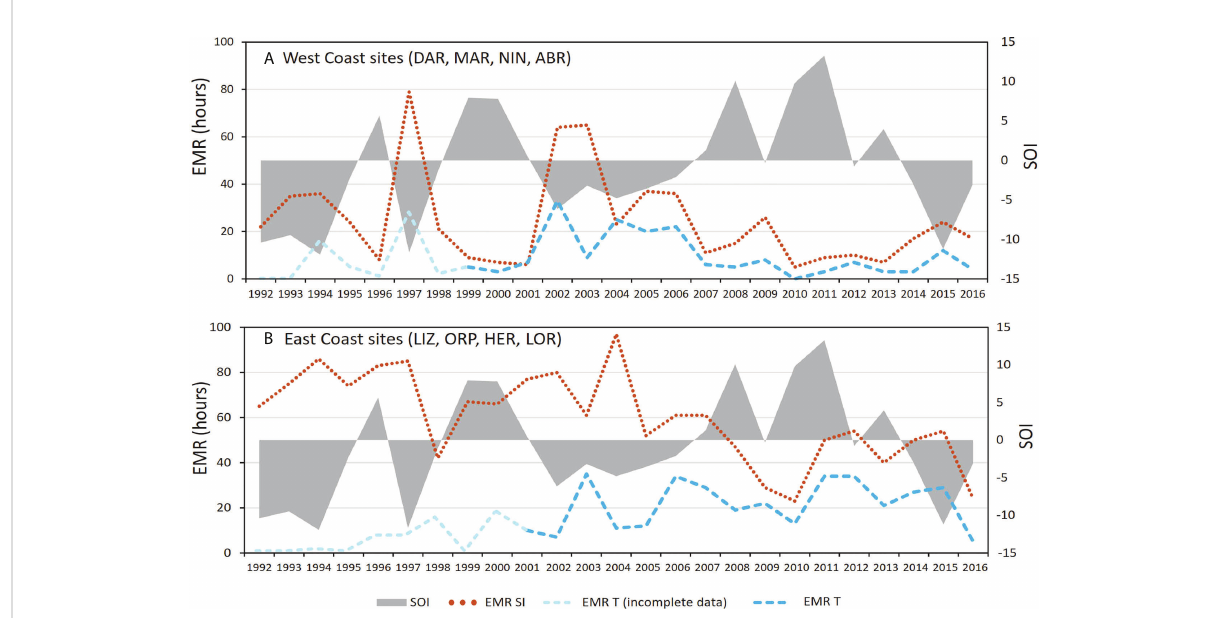
FIGURE 10 Total emersion mortality risk due to high solar irradiance (EMRSI 1) and low atmospheric temperature (EMRT w 1) for (A) West Coast sites (DAR, MAR, NIN and ABR) and (B) East Coast sites (LIZ, ORP. HER and LOR) combined, and the Southern Oscillation Index (SOI), from 1992 to 2016. Annual temperature data availability is indicated for each group of